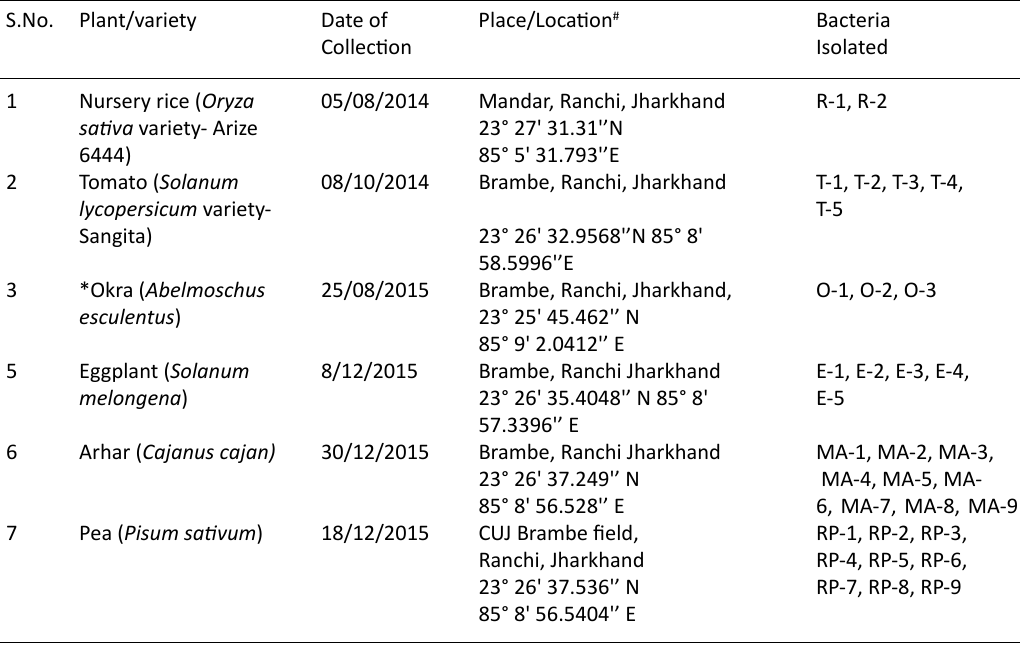
table 2 . General information about sources of bacterial isolates